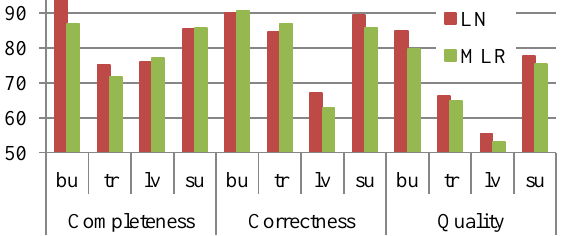
Figure 7. Completeness, correctness and quality per class (bu: building , tr: tree , lv: low vegetation ; su: impervious surfaces ) for the results in area 3 (Vaihingen). The results for version LN correspond to figure 6 (right).